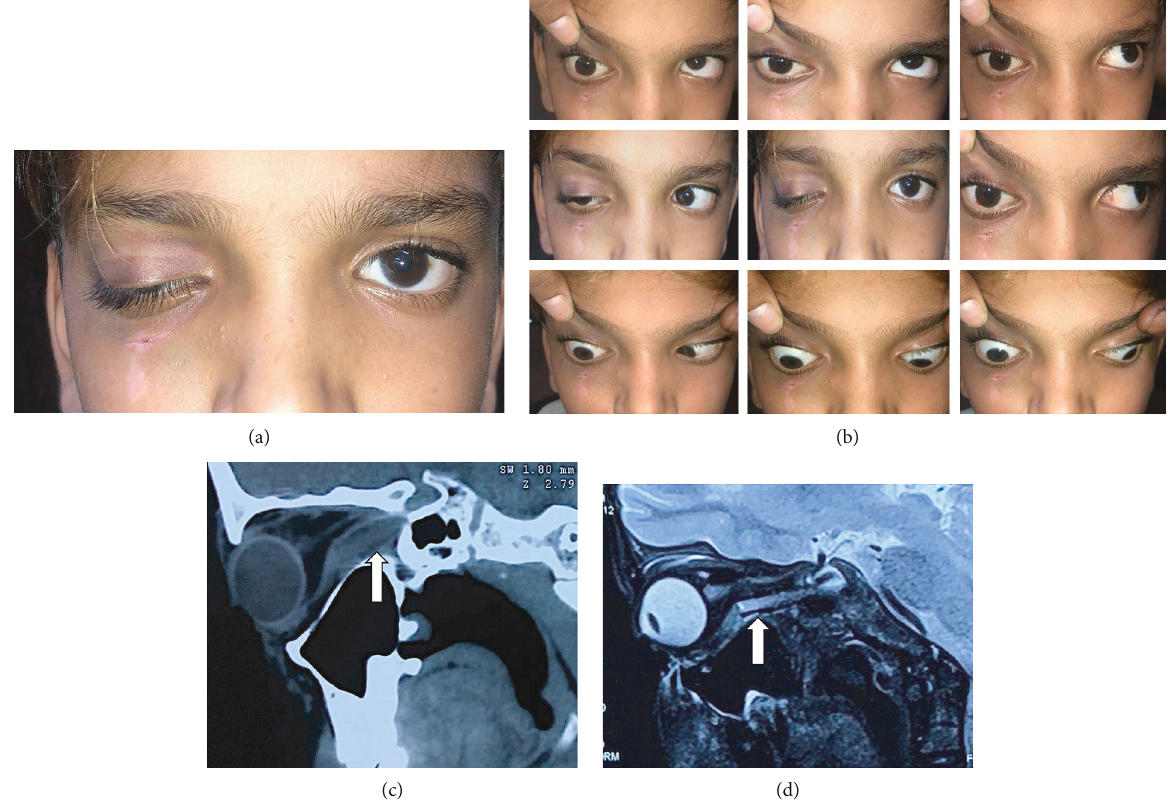
Figure 3: Illustrative case 2: (a, b) clinical examination showing ptosis, limitation of right extraocular movements, and an entry wound below the right lower lid; (c) NCCT orbit and (d) MRI orbit, sagittal view, reveal a nonmetallic object extending up to the apex (white arrow).